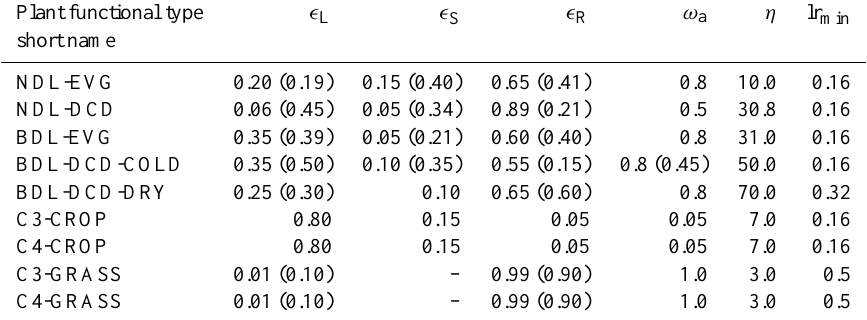
Table A4. PFT-specific base allocation fractions for leaf ( (cid:15) L ), stem ( (cid:15) S ) and root ( (cid:15) R ) components (Eqs. A41 to A43), the parameter ω a , which determines the sensitivity of allocation to light and water status, the parameter η (Eq. A46), which determines proportion of stem plus wood biomass to leaf biomass and the minimum root:shoot ratio lr min used in the allocation module of CTEM v. 2.0. Some parameter values differ between the model versions when PFTs’ fractional coverage is specified and when they are dynamically modelled using competition between PFTs. If modified, the parameter values for the dynamically modelled version are shown in parentheses. Plant functional